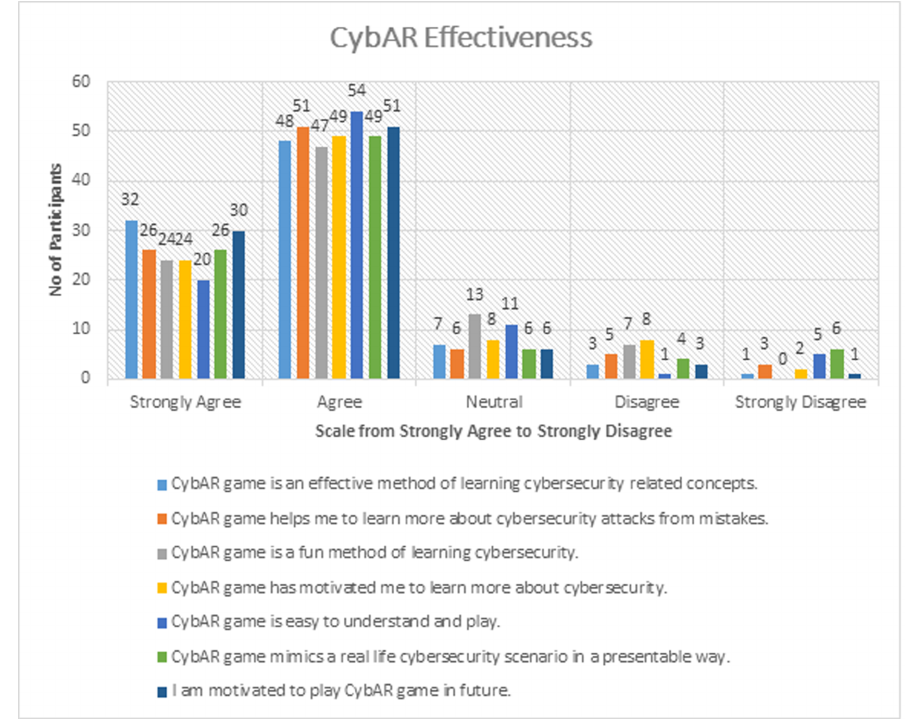
Figure 14. Survey responses on CybAR game.